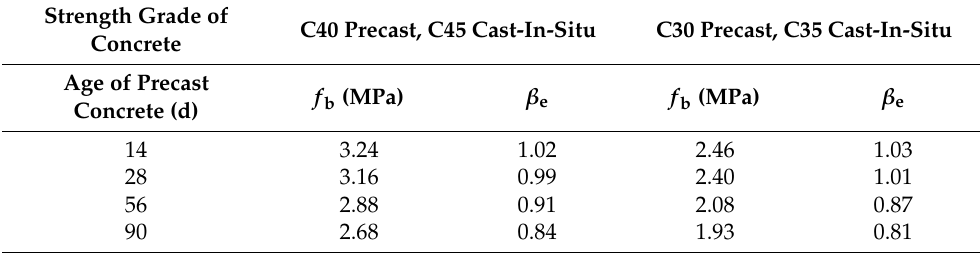
Table 11. Bond strength of interface with different storage time of precast concrete